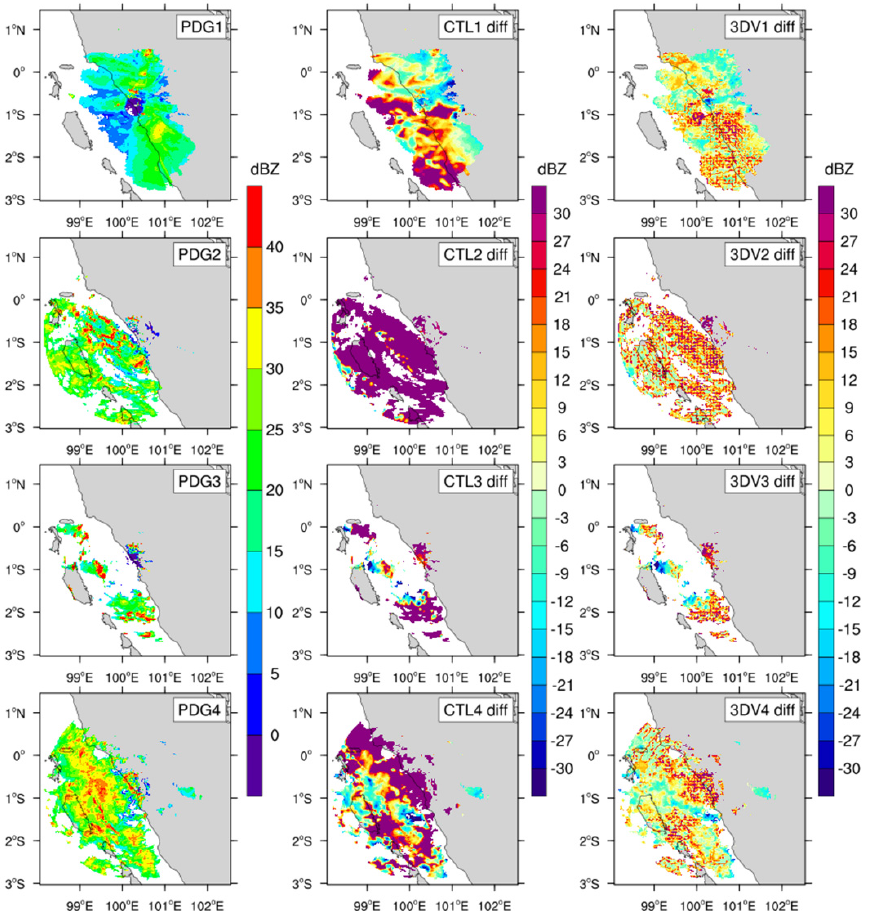
Figure 8. (Left) Composite radar reflectivity observations and departure from the (middle) CTL simulation and (right) 3DV simulation at 00 h in Cases 1–4. The numbers included in the panels indicate the corresponding case number.